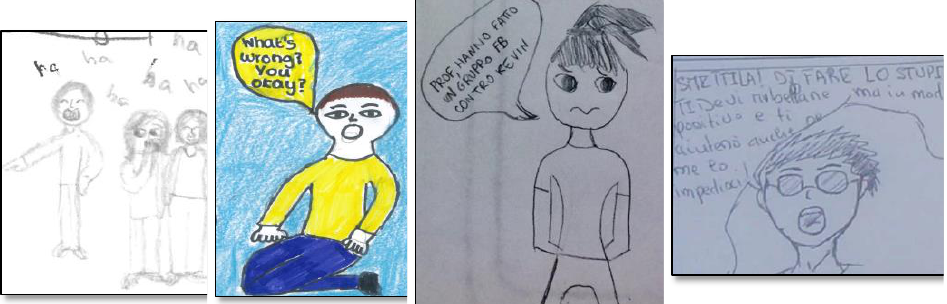
Figure 5. Examples of other roles’ emotions. From left to right: Joy (reinforcer), Surprise (defender), Sadness (defender), Anger (defender). The phrase “Prof. hanno fatto un Gruppo FB contro Kevin” means “Prof., they created a FB group against Kevin”; while the sentence “Smettila di fare lo stupido. Ti devi ribellare ma in modo positivo e ti aiuterò anche se me lo impedisci!” means “Stop being stupid. You have to rebel but in a positive way and I will help you even if you stop me!”.